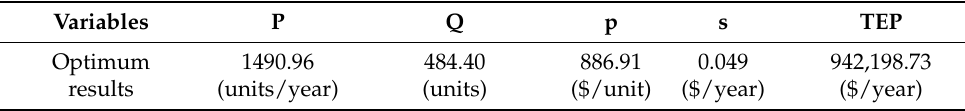
Table 7. Optimum results for the case without